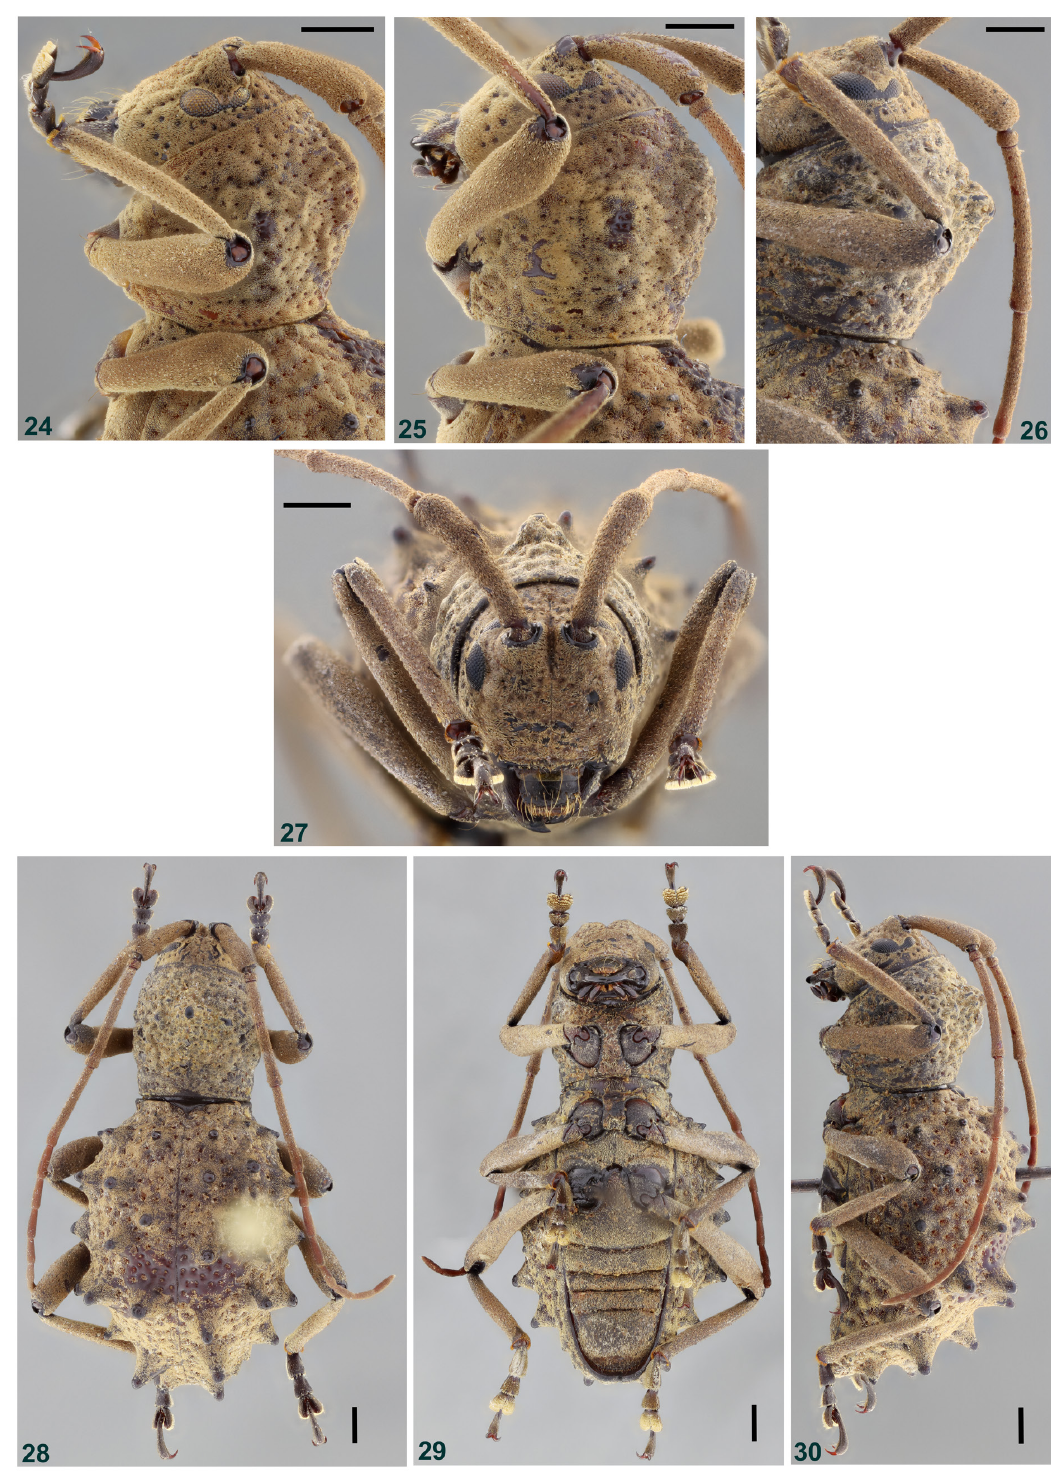
Figs 24–30. 24–25 . Phrynidius guifarroi sp. nov., prothorax, lateral view. 24 . Holotype, ♀ (RBINS 34.248). 25 . Paratype, ♀ (MZSP). — 26–30 . Phrynidius jonesi Gutiérrez, Toledo-Hernández & Noguera, 2020, ♂ (FSCA). 26 . Prothorax, lateral view. 27 . Head, frontal view. 28 . Habitus, dorsal view. 29 . Habitus, ventral view. 30 . Habitus, laetral view. Scale bars = 1.0